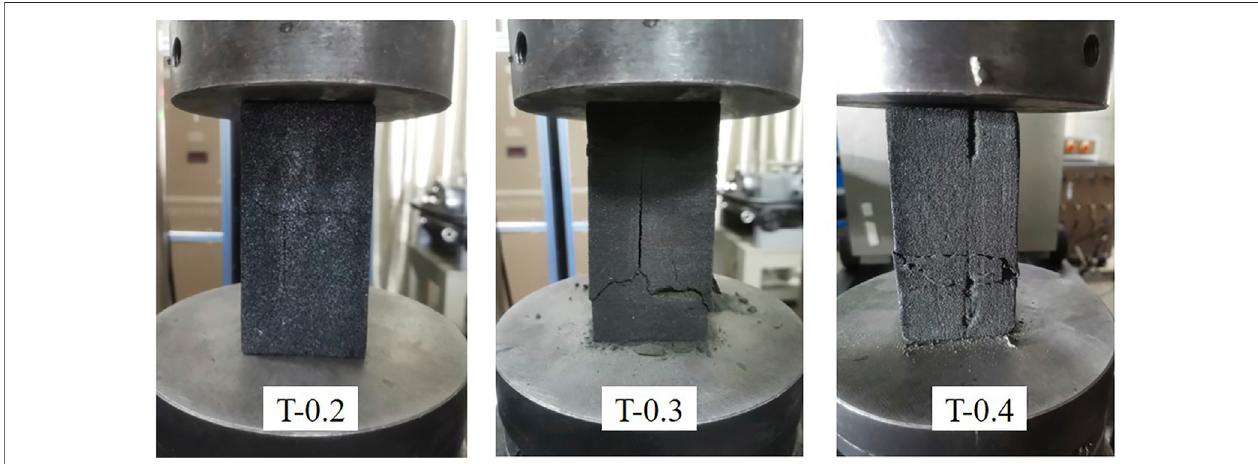
FIGURE 9 | Failure pattern of specimens with different layer thicknesses during the loading process.